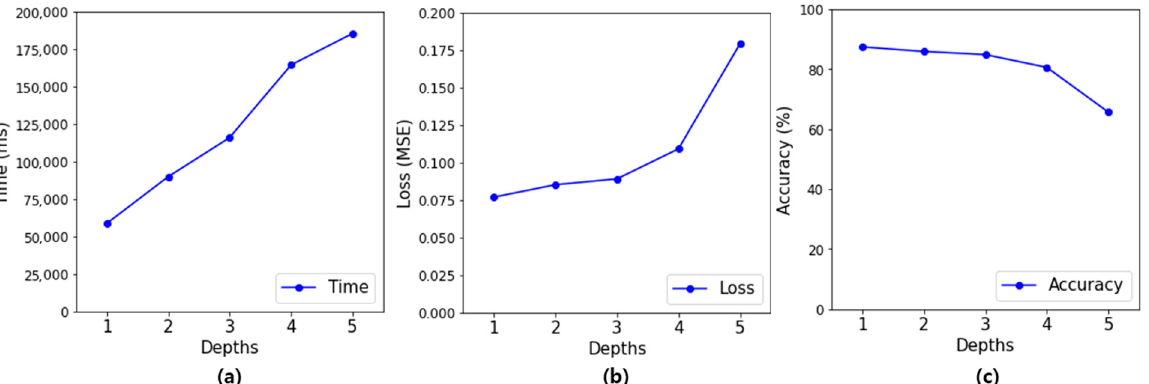
Figure 10. Performance graph of the evaluation model according to the depth of the hidden layer: ( a ) learning time according to the depth of the hidden layer; ( b ) loss according to the depth of the hidden layer; ( c ) accuracy according to the depth of the hidden layer.